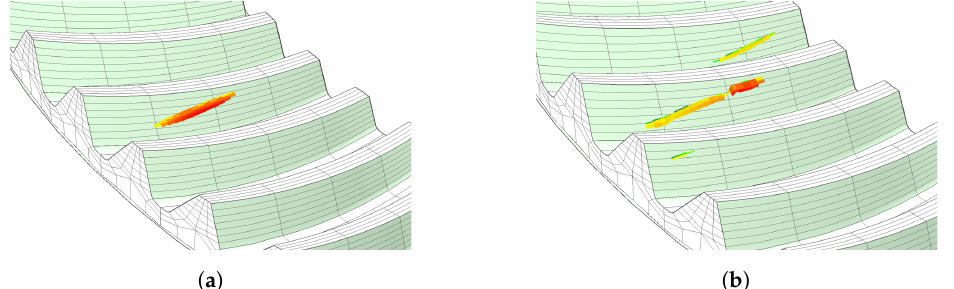
Figure 17. Instantaneous contact area(s) at the same meshing configuration on the gear before and after wear simulation (performed updating the geometry every 5 Mc). ( a ) Before wear. ( b ) After wear.